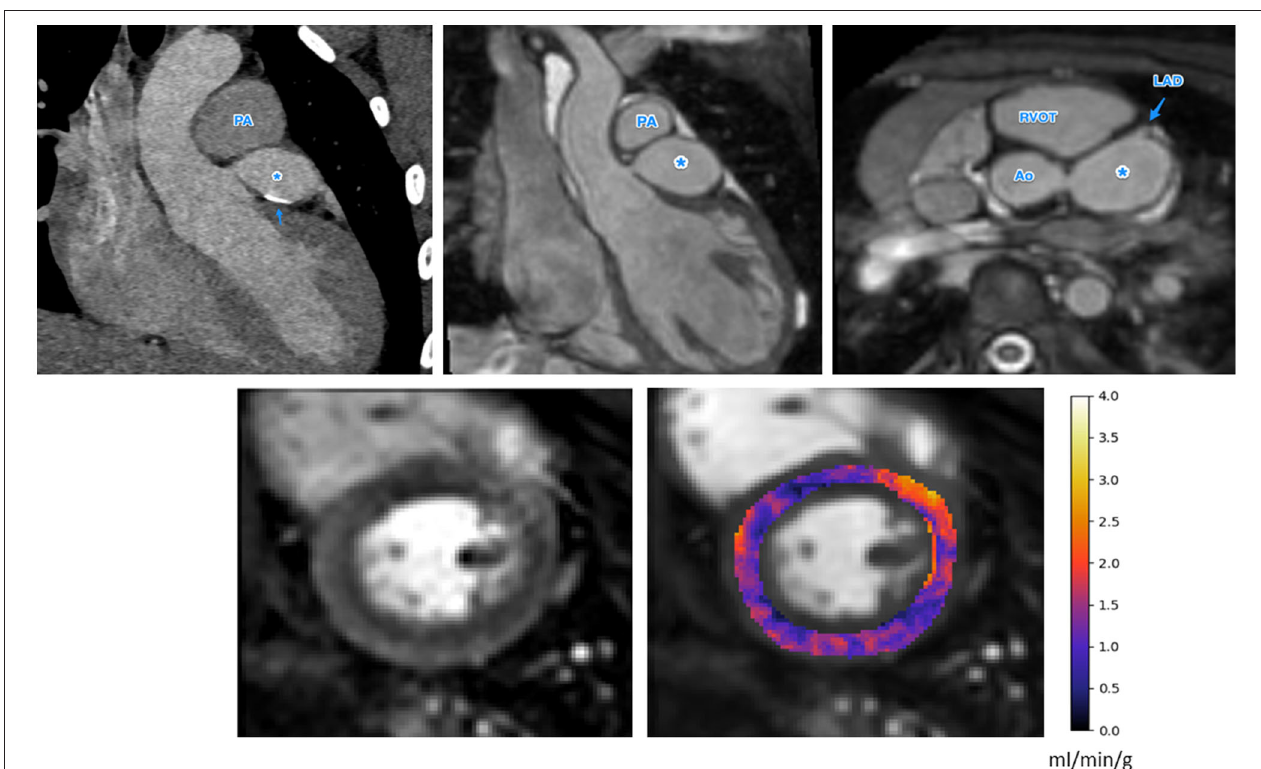
FIGURE 3 | The anatomical images (top row, CT left, MR center and right) and stress perfusion CMR with quantitative MBF map (bottom row) for a patient with Kawasaki disease and a giant aneurysm of the LMCA, indicated as *in the anatomical images. There is also calcification of the LMCA seen on the CT image (top left), indicated by the arrow. There is globally low MBF values, possibly indicating microvascular dysfunction (bottom right). Ao, Aorta; PA, pulmonary artery; MPA, main pulmonary artery; RVOT, right ventricular outflow tract; LAD, left anterior descending